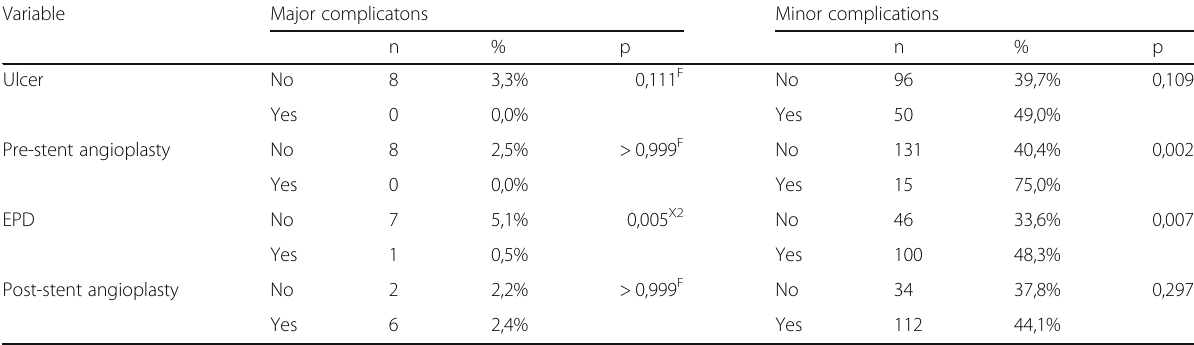
Table 3 The influence of procedural characteristics on peri-procedural complications